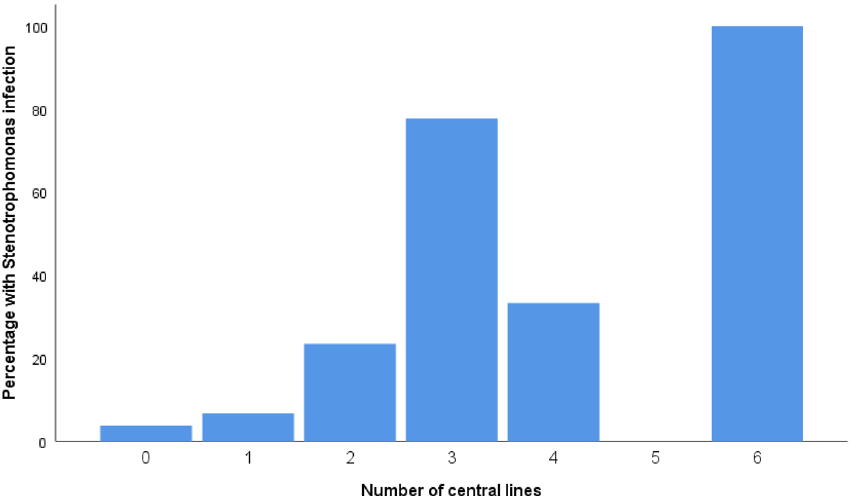
Figure 2. Relation between the probability of acquiring S. maltophilia pneumonia and the number of central lines installed during ICU